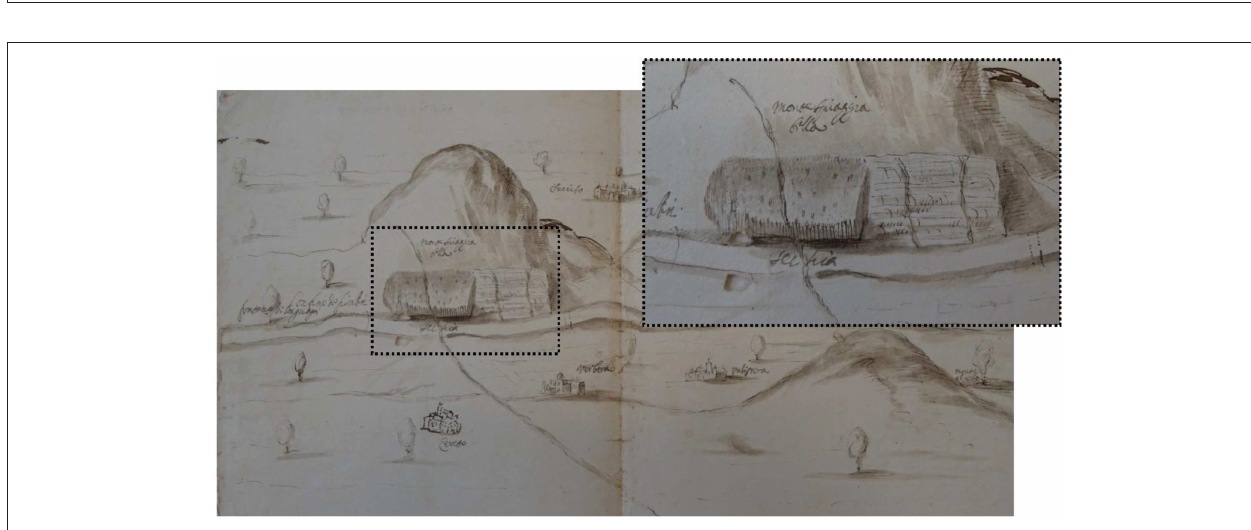
FIGURE 8 | ASP. Confini, B205/8, dis. 896. Upper Secchia valley: detail of an anonymous manuscript map; half 17th c. (attributed).